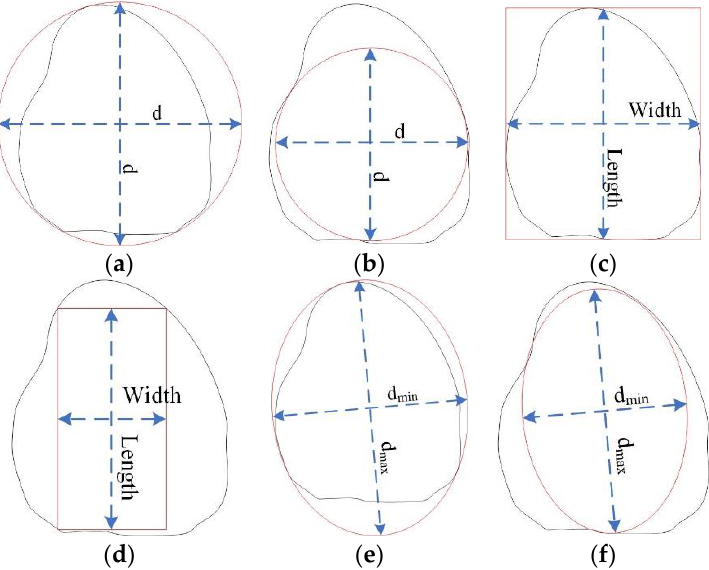
Figure 1. Models of pellet approximation: ( a , b )—pellet is approximated using a circle drawn around it and a circle drawn inside of it; ( c , d )—pellet is approximated using best fit rectangle drawn around it and rectangle drawn inside of it; ( e , f )—pellet is approximated using a ellipse drawn around it and a ellipse drawn inside of it.